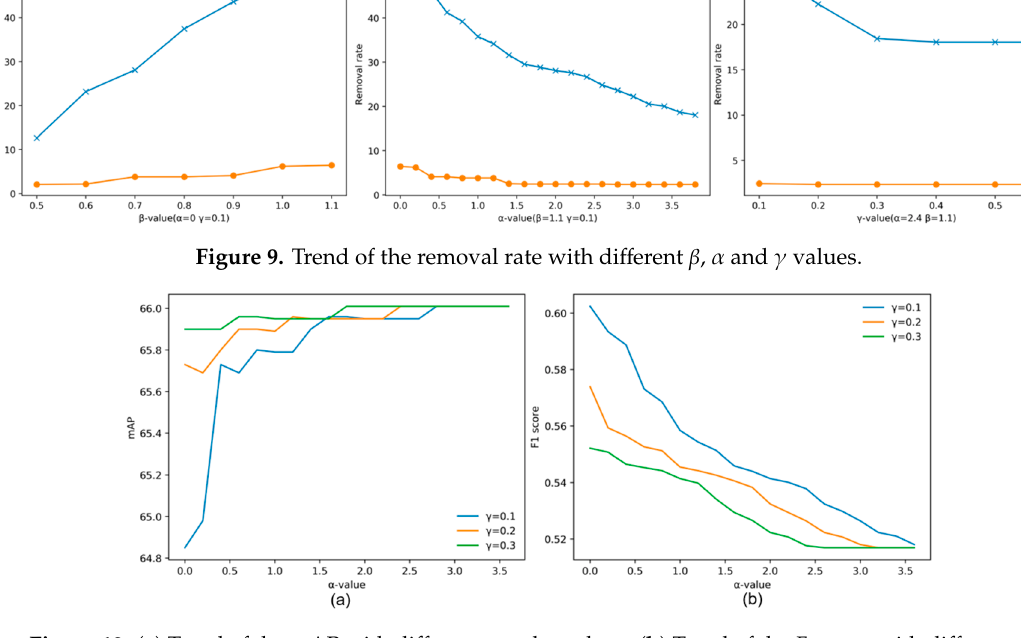
Figure 10. ( a ) Trend of the mAP with di ff erent α and γ values. ( b ) Trend of the F 1 score with di ff erent α and γ values.